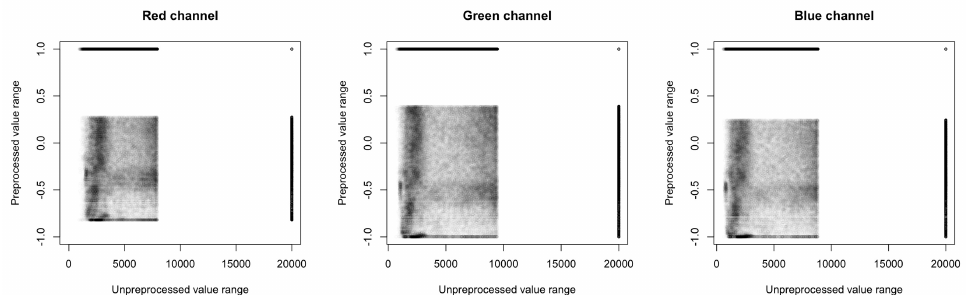
Figure A2. An example of comparison of “Unprocessed vs. Processed” values of each color channel. We found that, in the unprocessed data, the red channel tends to have a smaller range for the majority of values (excluding outliers), compared with the green and blue channels. Histogram equalization brings the ranges for all channels closer to one another, resulting in the color distortion visible in the visualization of the preprocessed data.